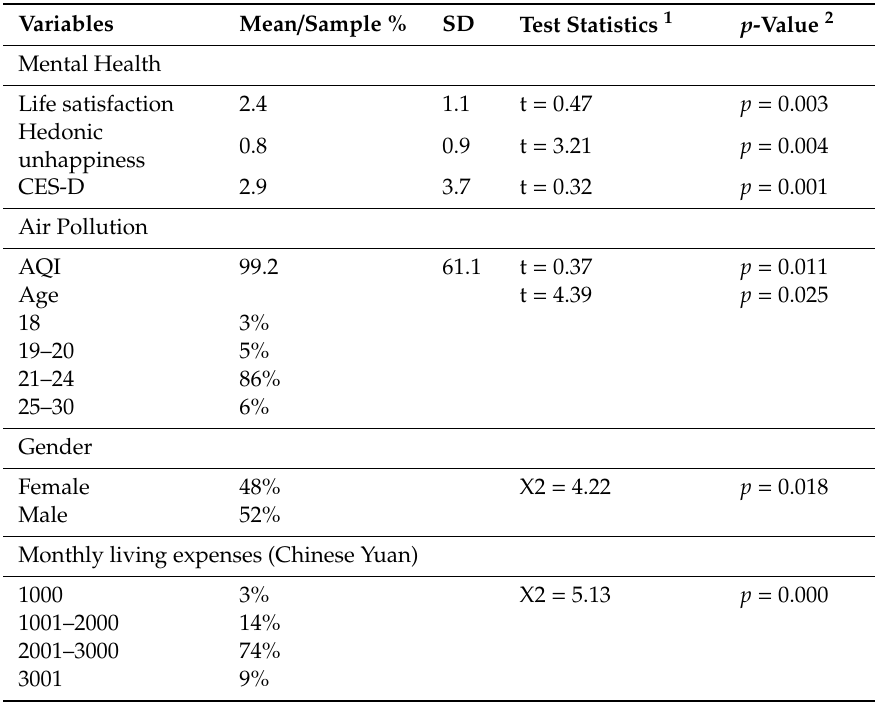
Table 1. Descriptive statistics (n =